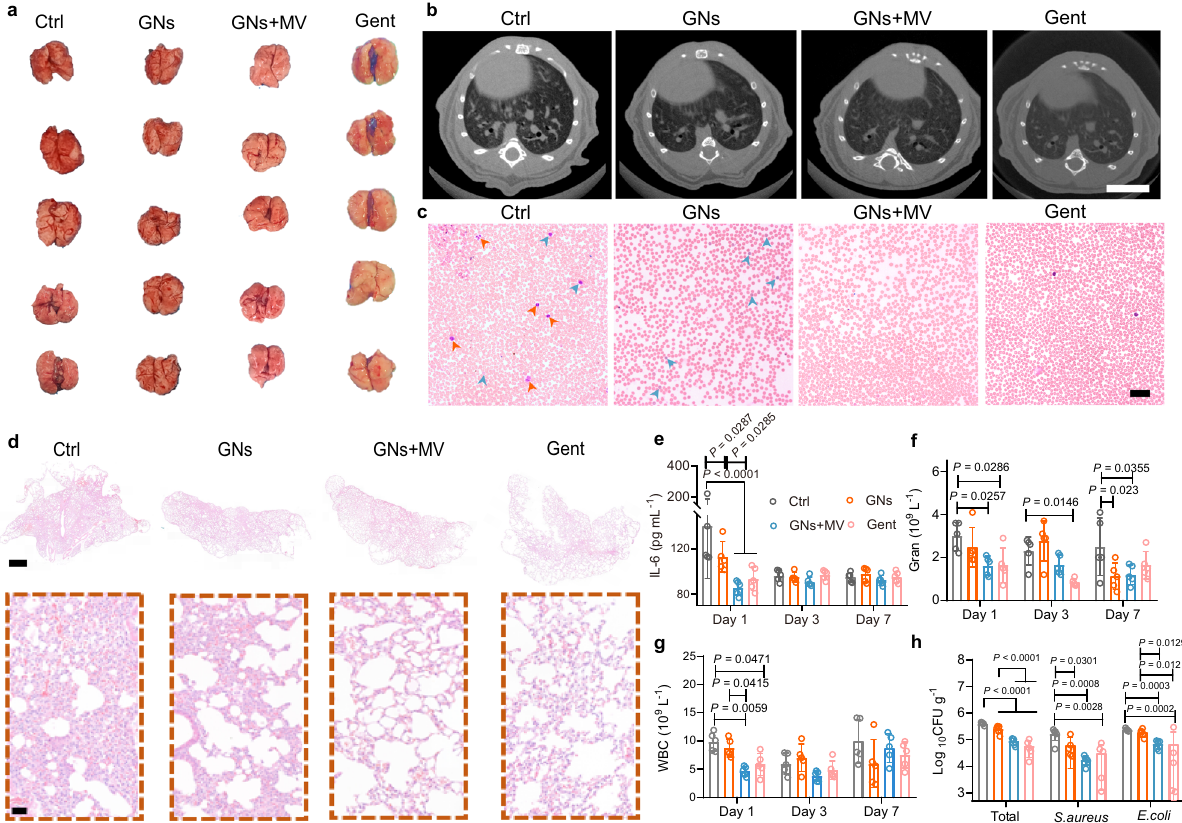
Fig. 7 Antibacterial effects of GNs on S. aureus and E. coli co-infected pneumonia in vivo. a Macroscopic images of lung tissue after 7 days of different treatments. b Micro-CT of lung in mice with co-infected pneumonia after 7 days treatment. Scale bars, 5 mm. c Representative Wright-stained images of blood in mice with co-infected pneumonia after one day of treatment. Scale bars, 20 μ m. d H&E staining images of infected lung tissues after 7 days of treatment. Scale bars, 1 mm and 20 μ m (enlarged view). e - g , IL-6 levels ( e ), amount of Gran ( f ) and amount of WBC ( g ) from 1 to 7 days in blood. h Bacteria counts in the infected lung after one day with different treatments. Data are presented as mean ± standard deviations from a representative experiment ( n = 5 biologically independent samples). P values were analysed by two-way ANOVA with Tukey ’ s multiple comparisons post hoc test. Source data are provided as a Source Data fi